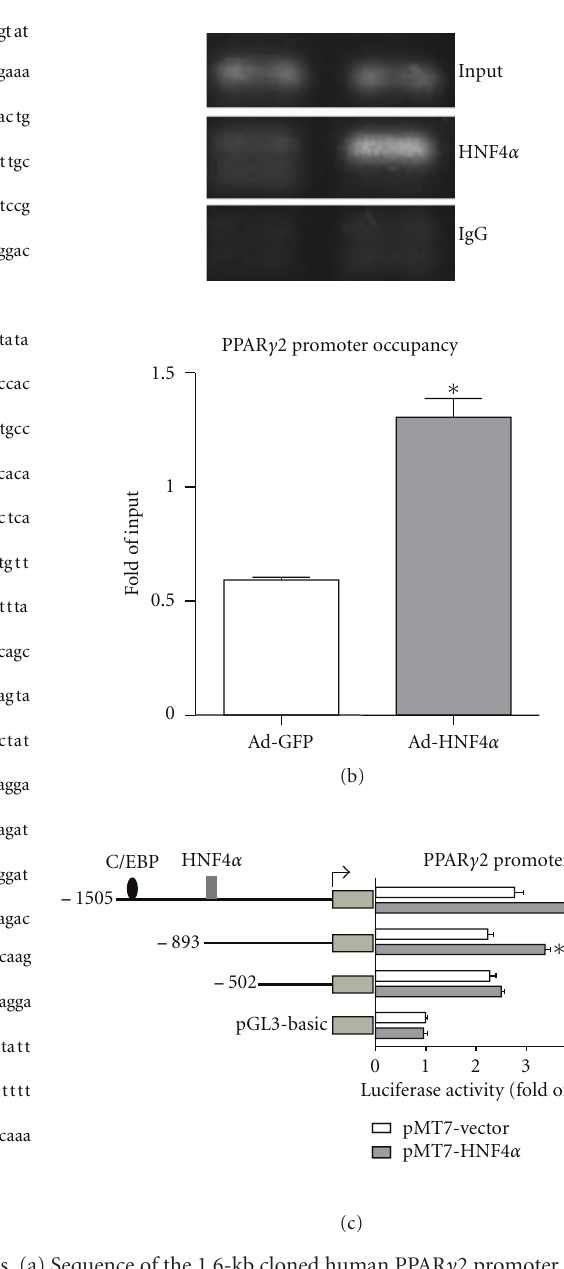
Figure 2: HNF4 α transactivated PPAR γ 2 promoter in hepatocytes. (a) Sequence of the 1.6-kb cloned human PPAR γ 2 promoter and sketch of putative HNF4 α binding site. (b) HepG2 cells were infected with or without adenovirus HNF4 α (Ad-HNF4 α ) for 24hr and underwent chromatin immunopreciptitation (ChIP) assay with anti-HNF4 α antibody; normal rabbit IgG was used in control experiments. qPCR was used with PPAR γ promoter-specific primers to detect binding of HNF4 α to the PPAR γ 2 promoter. The DNA levels were normalized to that of input and expressed as fold of the control group. ∗ P < 0 . 05. (c) HepG2 cells were cotransfected with plasmids of PPAR γ 2p1505- Luc, PPAR γ 2p893-Luc, or PPAR γ 2p502-Luc with pMT7-HNF4 α or vehicle plasmid. The β -gal plasmid was cotransfected as a transfection control. Promoter activities were measured by relative luciferase activity, with the level normalized to that of β -gal, from 3 independent experiments, each performed in triplicate. Data are mean ± SD. ∗∗ P < 0 . 01 compared with